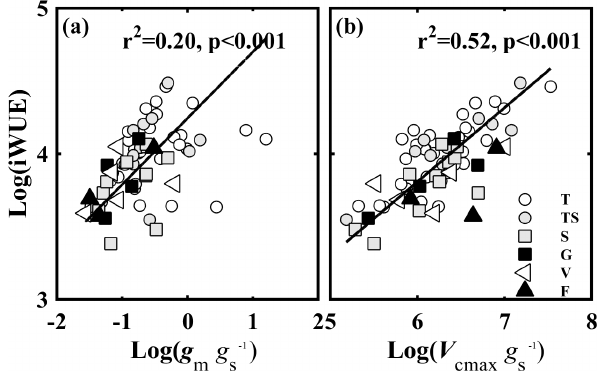
Figure 7. The relationships of the intrinsic water use efficiency (iWUE, µmolCO 2 mol − 1 H 2 O) and (a) the ratio of mesophyll con- ductance to CO 2 (g m ) to ( g s ) ( g m /g s ) , and (b) the ratio of the max- imum carboxylase activity of Rubisco ( V cmax ) to g s ( V cmax /g s ) . Lines refer to regression line for 63 species. T, TS, S, G, V, and F represent tree, tree/shrub, shrub, grass, vine, and fern,